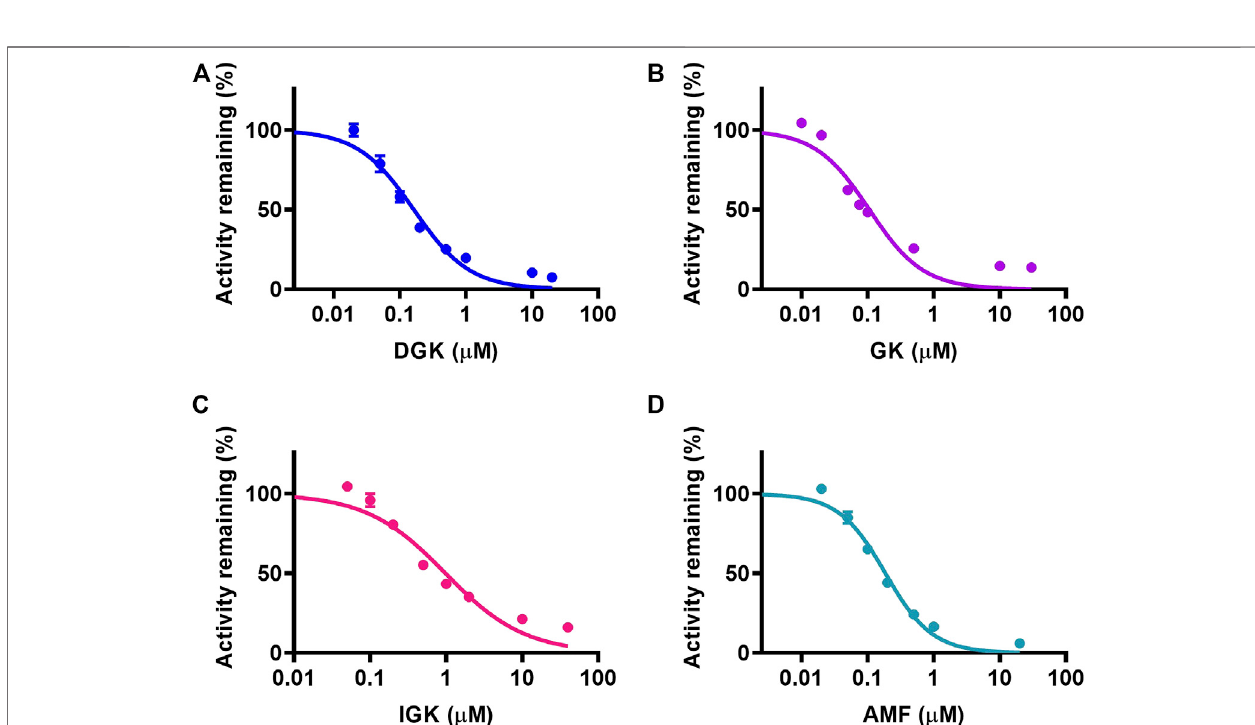
FIGURE 3 | The concentration-dependent inhibitory effects of four identi fi ed bi fl avones against NEN-4-hydroxylation in HLM. (A) DGK, (B) GK, (C) IGK, and (D) AMF. Data are shown as the mean ± S.D. ( n = 3). Each line represents the line of best fi t to the data.